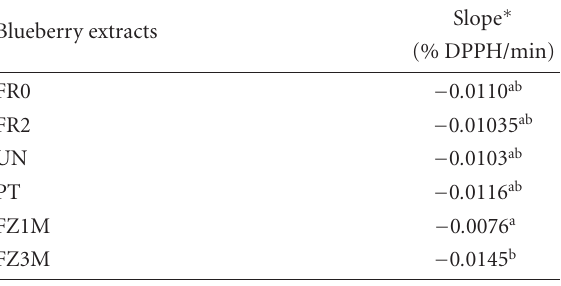
Table 2. Average slope values of blueberry extracts. Blueberry